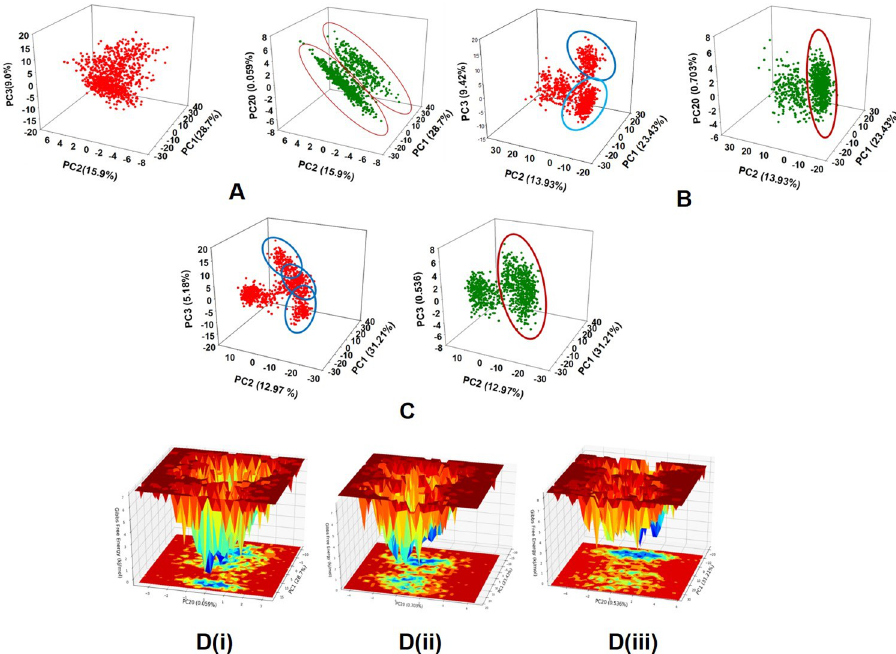
Fig 7. PCA plots of four PC modes where PC1 the highest variance and PC20 the lowest variance Eigen values. PC2 and PC3 are the second and third highest variances respectively. The 3D PCA plots of among PC1, PC2 and PC3 (in left panel) and PC1, PC2 and PC20 (right panel) displayed for (A) BCL-2, (B) JAK2 and (C) Cyp2E1, bound to quercetin molecule. The round up zones in the PCA plots displaying the clustered trajectories in the respective modes. The representation of free energy landscape (FEL) against PC1 and PC2 for the proteins (D) (i) BCL-2, (ii) JAK2 and (iii) Cyp2E1,